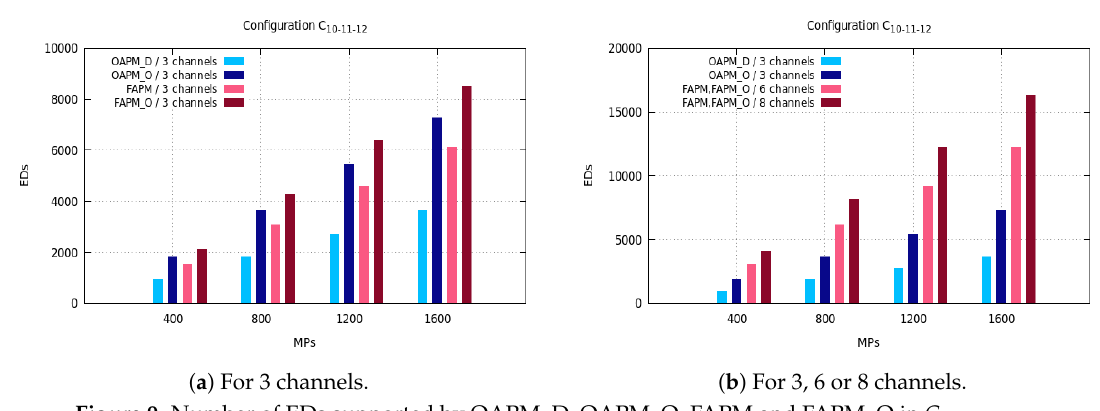
Figure 9. Number of EDs supported by OAPM_D, OAPM_O, FAPM and FAPM_O in C 0,0,0,33,33,33 .